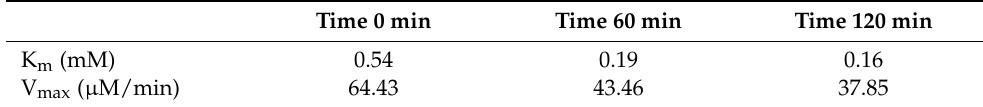
Table 2. Laccase kinetic constants after protease treatment.